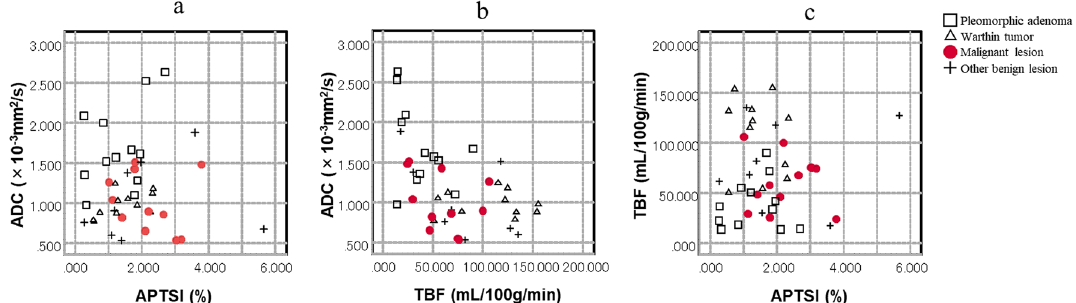
Figure 2. Scatterplot of ADC versus APTSI ( a ), ADC versus TBF ( b ), and TBF versus APTSI ( c ) of salivary gland lesions. Values of pleomorphic adenoma tend to cluster in the area of high ADC and low TBF and APTSI. Values of Warthin tumors tend to cluster in the area of low ADC and APTSI and high TBF. Values of malignant lesions tend to cluster in area of low ADC and TBF and high APTSI.